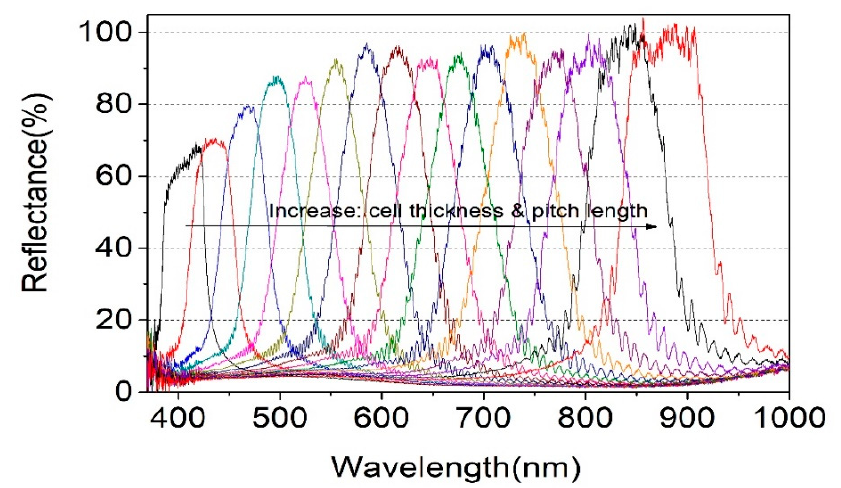
Figure 7. Spectra from the continuous tunable bandpass filter system. Data are shown in a low density to distinguish one by one easily.